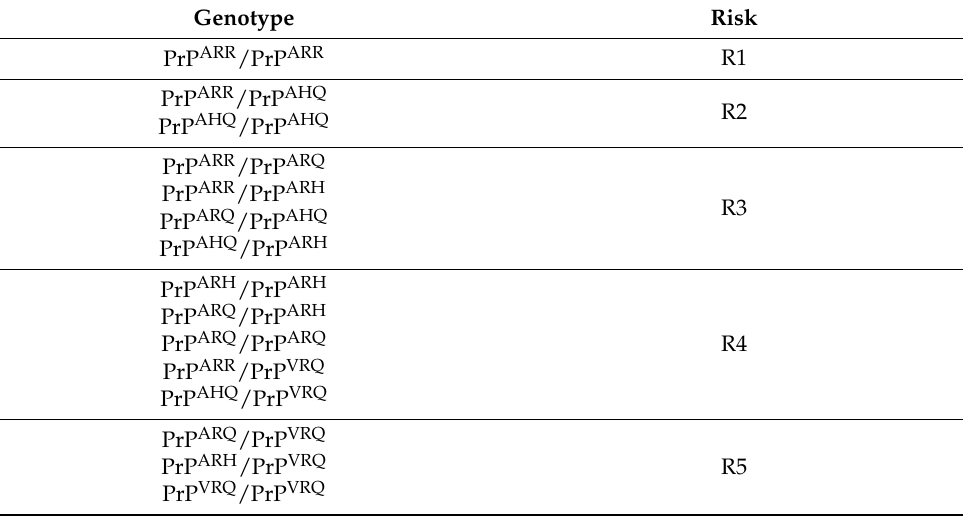
Table 2. Classical scrapie in sheep. Risk groups and genotypes. Adapted from Dawson and collaborators